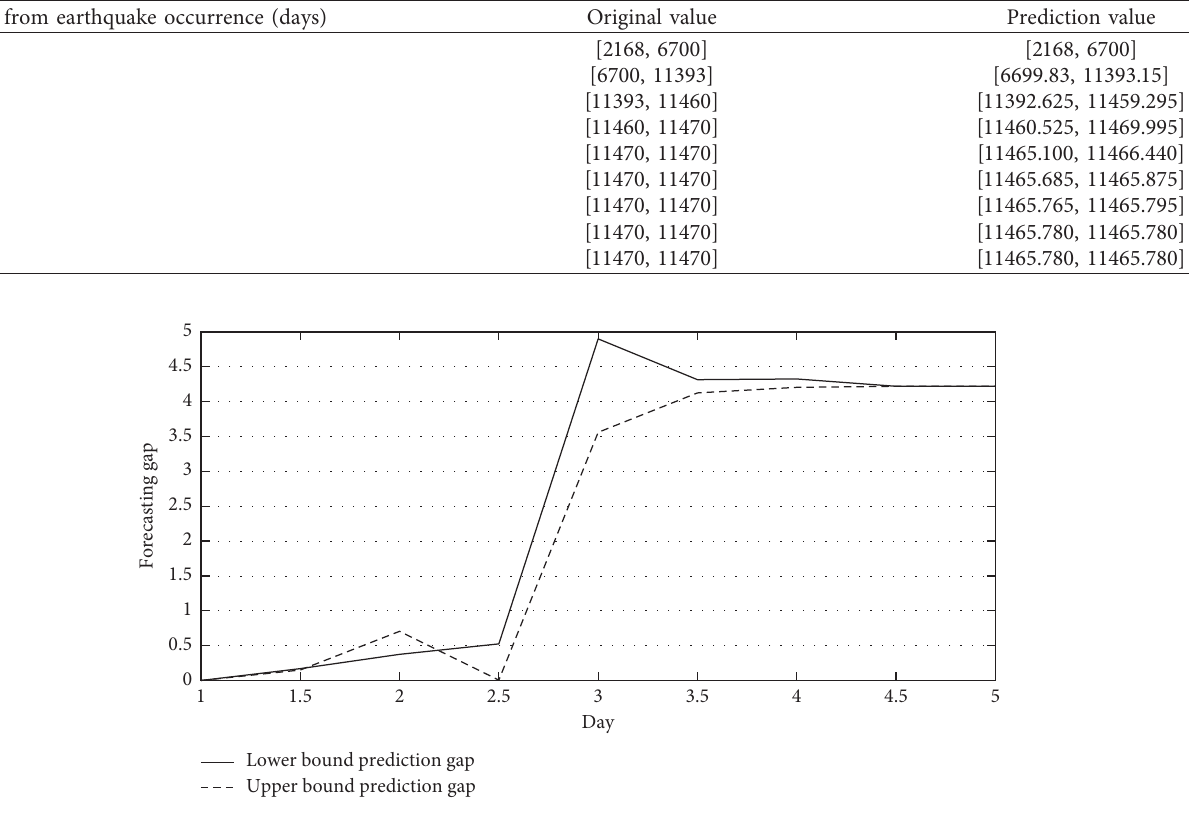
Figure 2: Prediction gap of the number of the